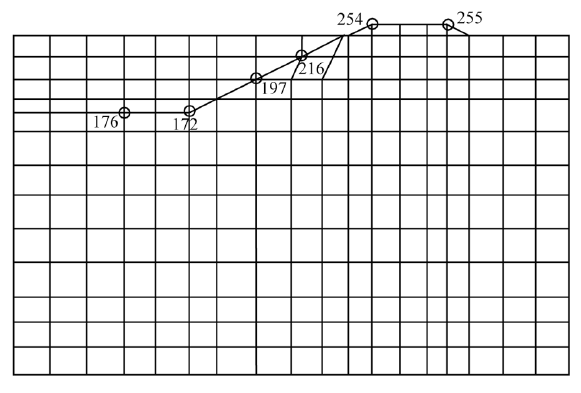
Fig. 5. FEM mesh for calculation of slope K2+300 (m)